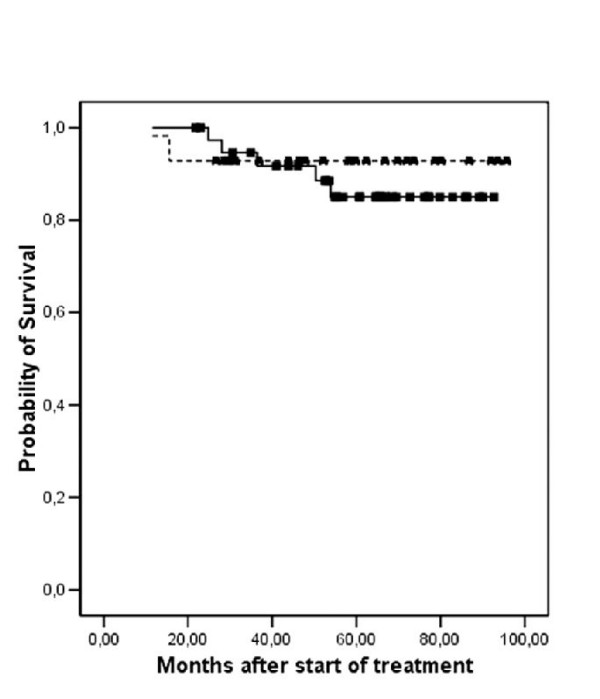
Overall survival of patients with stages Ia/Ib OR tumor grade 1 (--) vs. stages Ic/IIa/IIb AND tumor grade 2/3 (-).